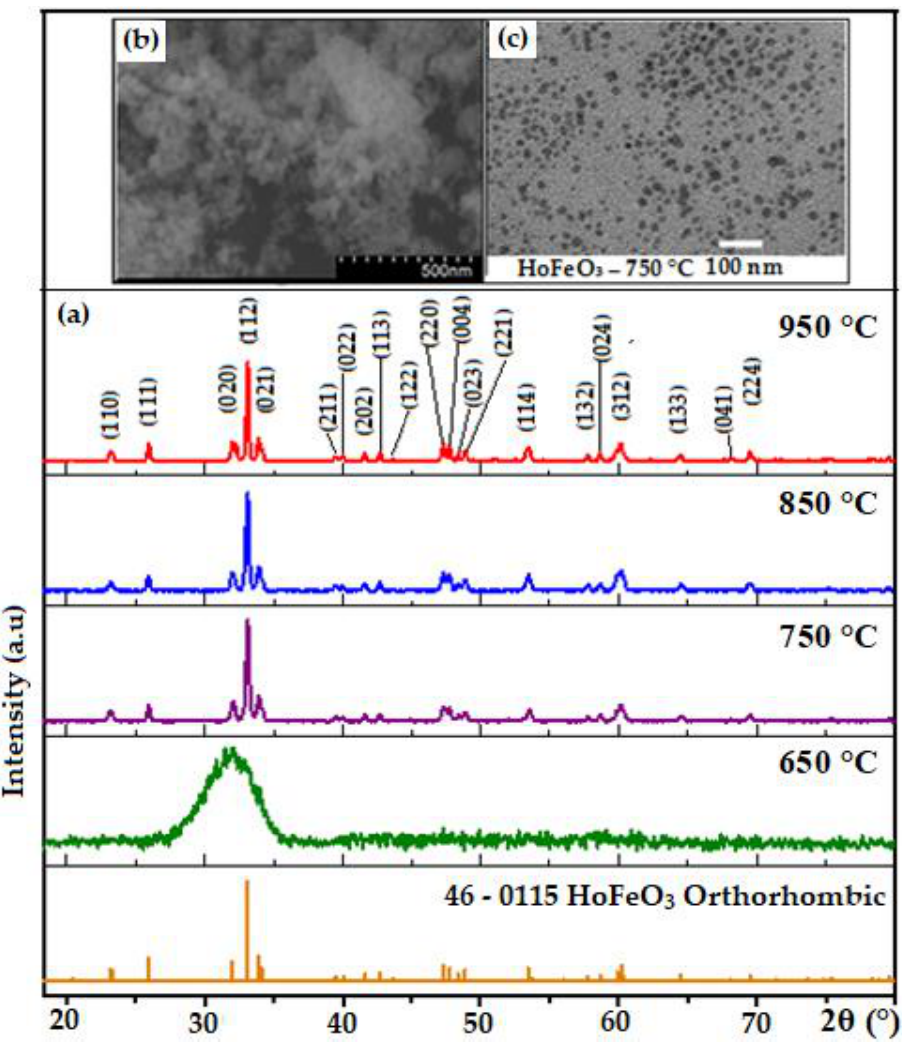
Figure 2. XRD patterns of the nano-sized HoFeO 3 particles annealed at 650, 750, 850 and 950 °С for 1 h ( a ) and SEM ( b ), TEM ( c ) of the HoFeO 3 annealed at 750 °С for 1 h.